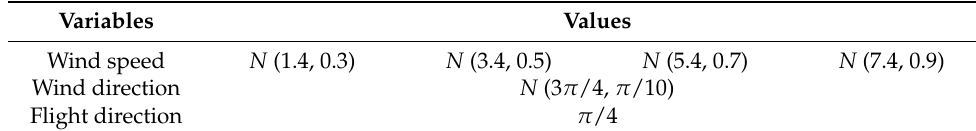
Table 8. Parameters for different wind speeds.